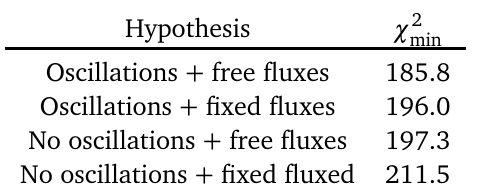
Table 1: χ 2 either assuming neutrino oscillations or not, and free or fixed fluxes. min Data extracted from Ref. [ 13 ]